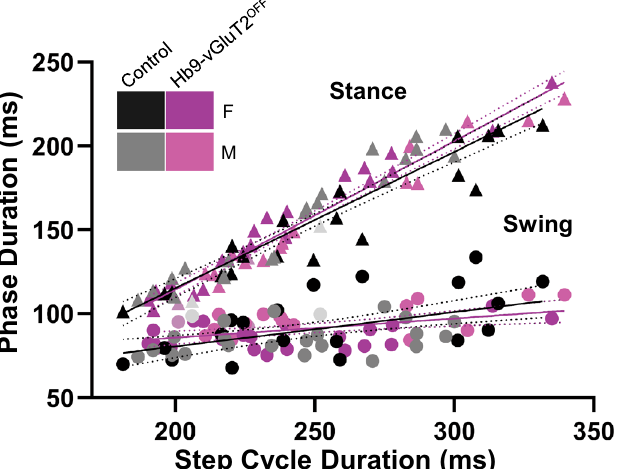
Figure 7. Relationships between phase duration and step cycle duration in Hb9-vGluT2 OFF mice were similar to controls. There was no significant difference in the relationship between stance phase and speed (Control R 2 = 0.89, Hb9-vGluT2 OFF R 2 = 0.95, P = 0.2), and no difference in swing phase in relation to speed (Control R 2 = 0.28, Hb9-vGluT2 OFF R 2 = 0.25 P = 0.15). The numbers of mice tested at treadmill speeds of 15, 20, 27, and 30 cm/s were: Control 11 (5 females), 12 (5 females + 1 not specified), 11 (5 females + 1 not specified), and 8 (4 females), respectively (total n = 12), and for Hb9-vGluT2 OFF mice: n = 10 (6 females), 11 (6 females + 1 not specified), 9 (5 females + 1 not specified), and 9 (5 females), respectively (total n = 11). Black: Control Female; Gray: Control Male; Light grey: Control sex not specified; Purple: Hb9-vGluT2 OFF Female; Pink: Hb9- vGluT2 OFF Male; Lavender: Hb9-vGluT2 OFF sex not